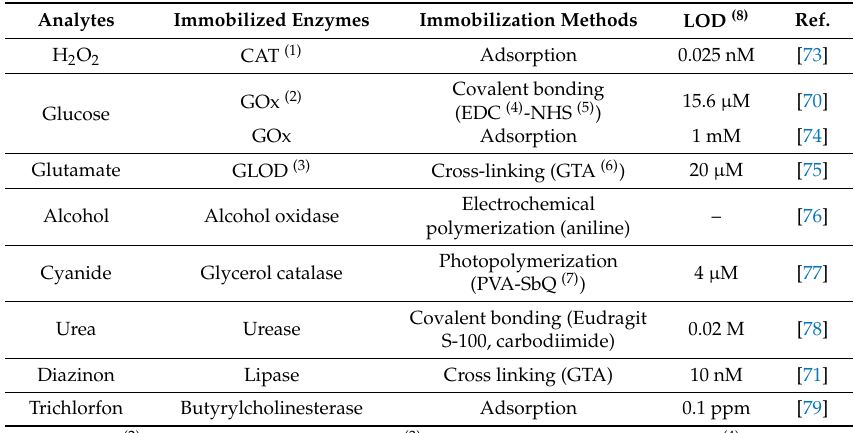
Figure 6. Schematic representation of an L -lactate selective impedimetric biosensor based on a LDH/ PyrOx bioselective membrane. Adapted from [72]. PyrOx: pyruvate oxidase; LDH: lactate dehydrogenase; BSA: bovine serum albumin; GA: glutaraldehyde; NAD + : nicotinamide adenine dinucleotide. Table 2. Summary of analytes, immobilized enzymes, immobilization methods, and LODs of impedimetric enzyme biosensors.